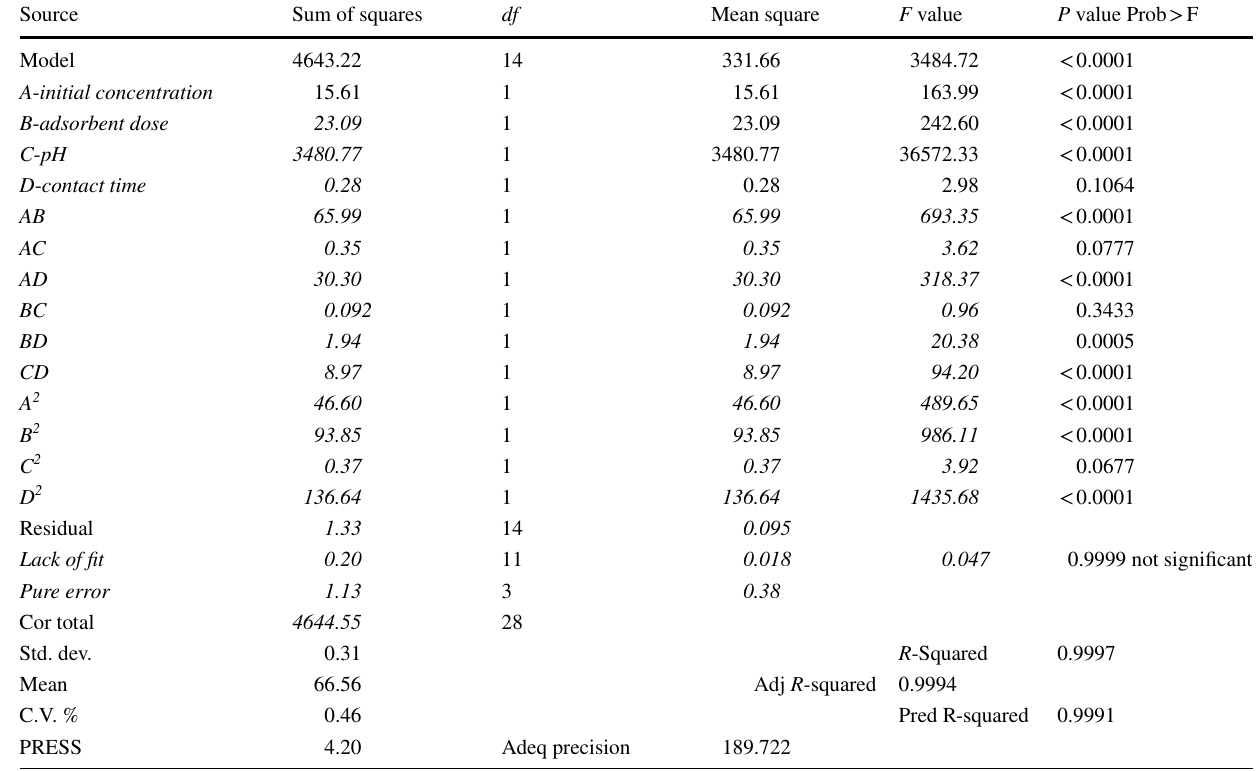
Table 5 Analysis of variance (ANOVA), regression coefficient estimate and test of significance for Cr(VI) removal on Aspergillus niger Source Sum of